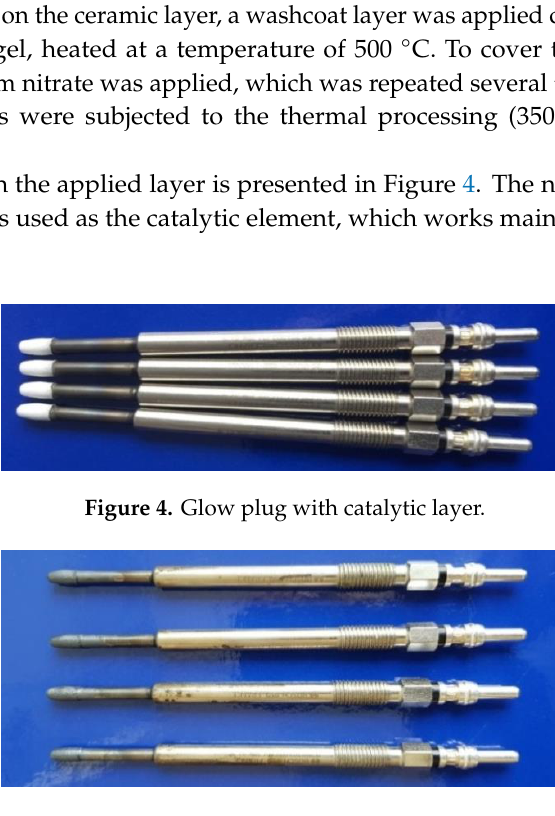
Figure 5. Glow plug with the catalytic layer (heating part–30 mm).